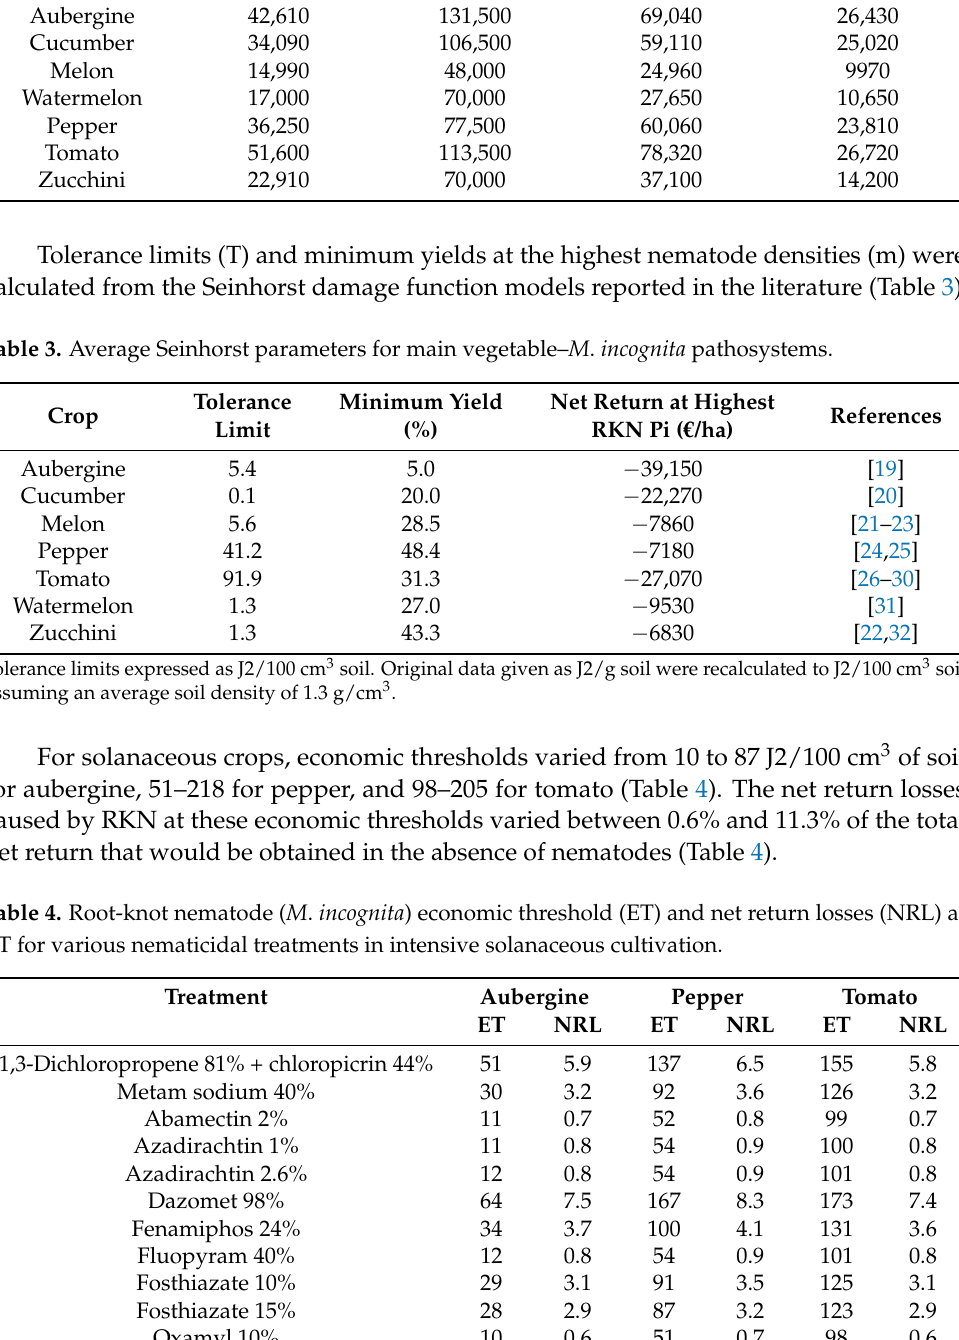
Table 2. Costs, yields, revenues, and net returns for vegetable crops in intensive vegetable cultivation in southern Spain for the 2019, 2020, and 2021 seasons [12]. Cost Yield ( € /ha) (kg/ha) ( € /ha) Aubergine